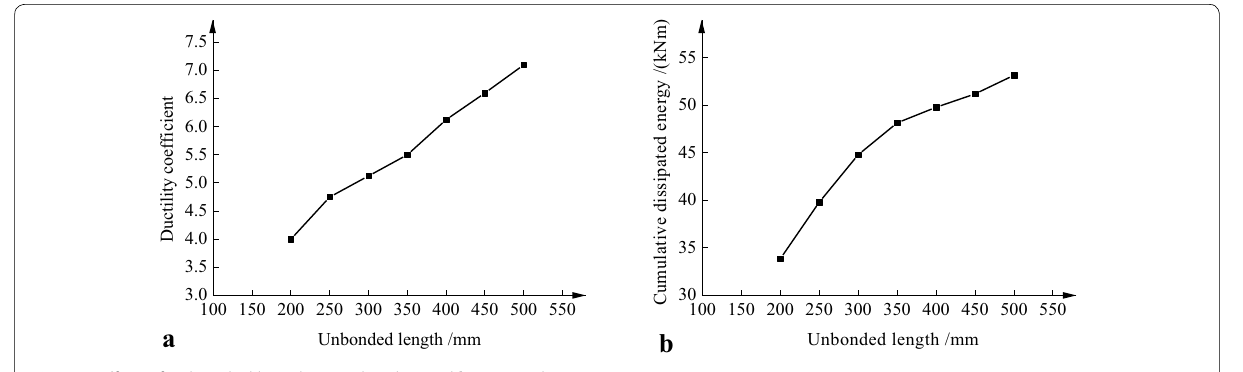
Fig. 14 Effect of unbonded length on a ductility and b energy dissipation.